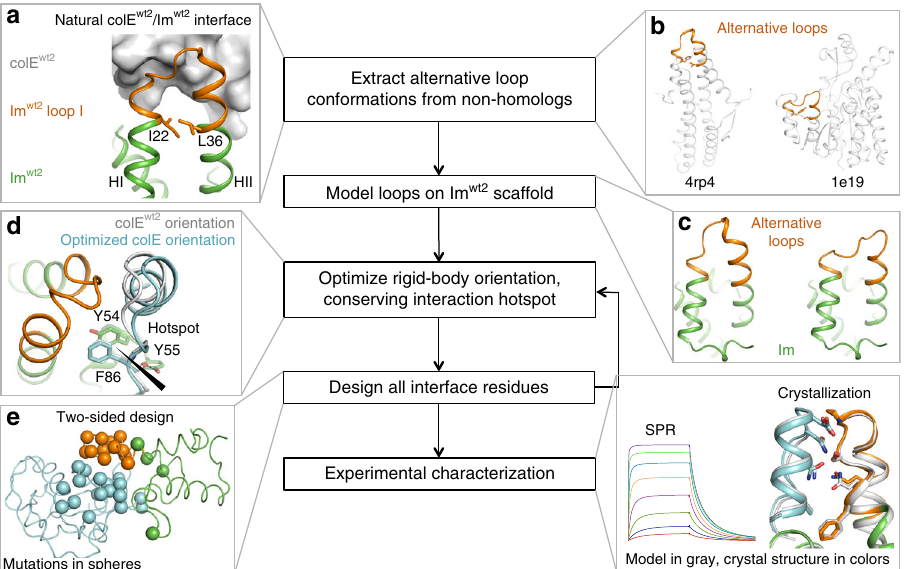
Fig. 1 Key steps in the design of high-speci fi city protein pairs. The algorithm was implemented on the bacterial colicin colE wt2 /Im wt2 complex. a Loop I (gold) on Im wt2 at the interaction interface was chosen as a site for backbone design. The fl anking helices I and II are denoted as HI and HII. The loop stem side chains are shown in sticks. b Alternative loops (gold) of diverse conformations and sequence lengths, which exhibit stem geometry compatible to that of loop I, were found in non-homologous protein structures. c The matching conformations were placed on the Im instead of the natural loop I. d Each Im conformation was docked against the colE using the natural hotspot interaction (in sticks) as a pivot for rotation (indicated in black). e For each design pair, the sequence of the entire interface, including loop I and both chains but excluding the hotspot region, was designed (spheres) to maximize